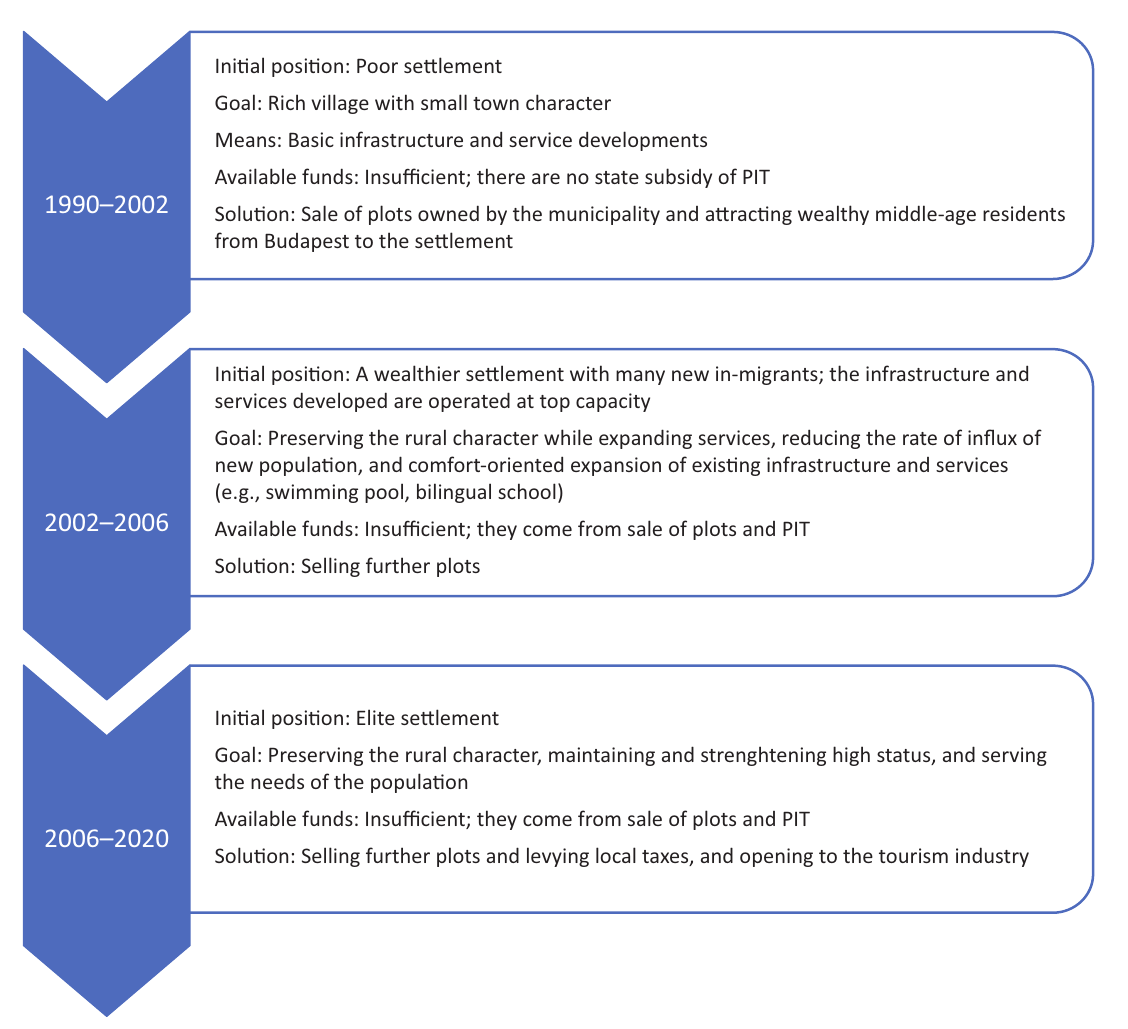
Figure 3. The goals of the local government and the funds allocated to the goals in the three periods under